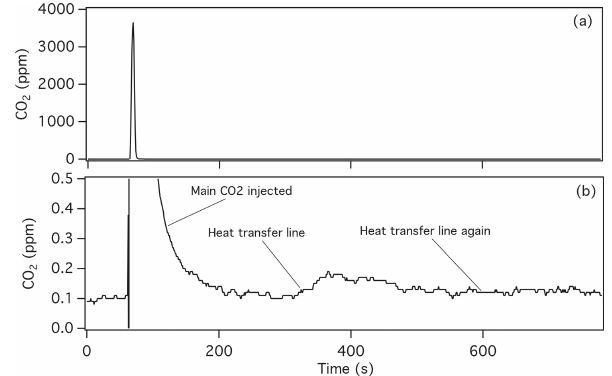
Figure 3. Normalized response of gravimetrically prepared stan- dards, analyzed by laser spectroscopy (b) . Residuals from linear fit are shown in (a) , along with preparation uncertainties ( ∼ 68% con- fidence level, or coverage factor k = 1).